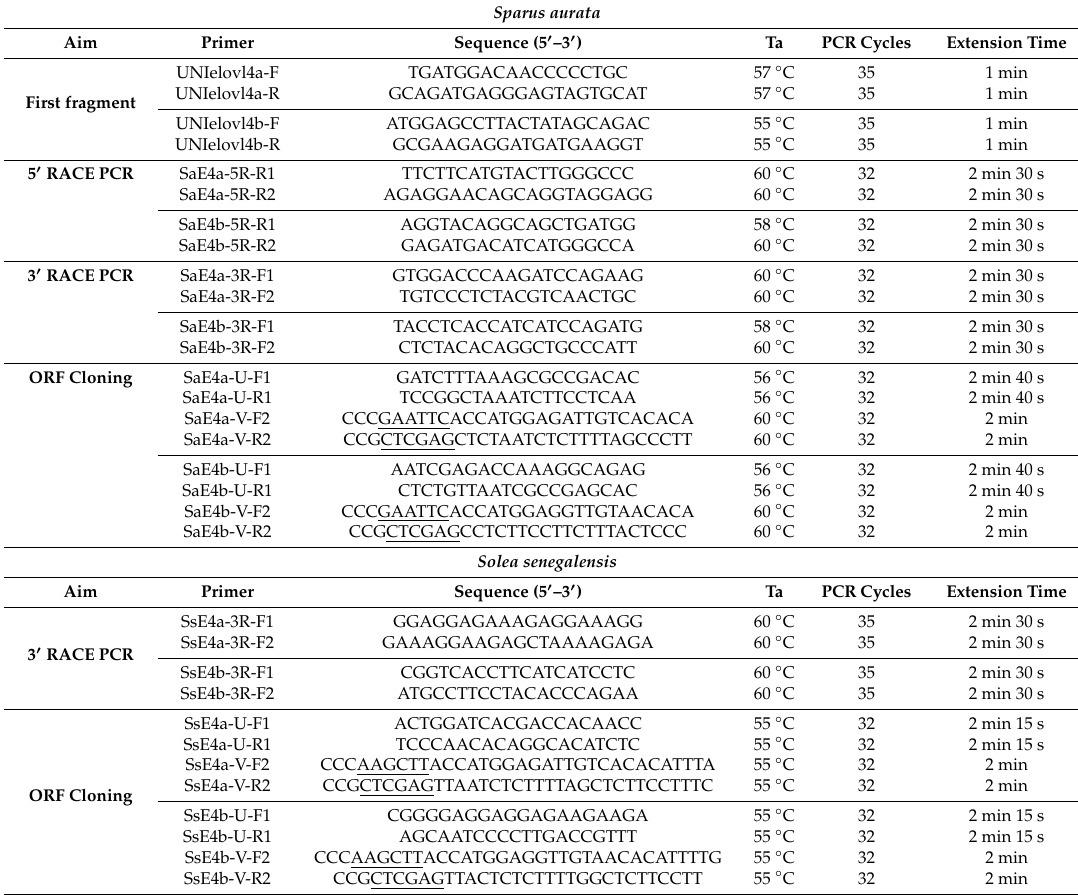
Table 5. Nucleotide sequences of primers (Forward: F; Reverse: R) used for DNA open reading frame (ORF) cloning of Sparus aurata and Solea senegalensis elovl4a and elovl4b . Sparus